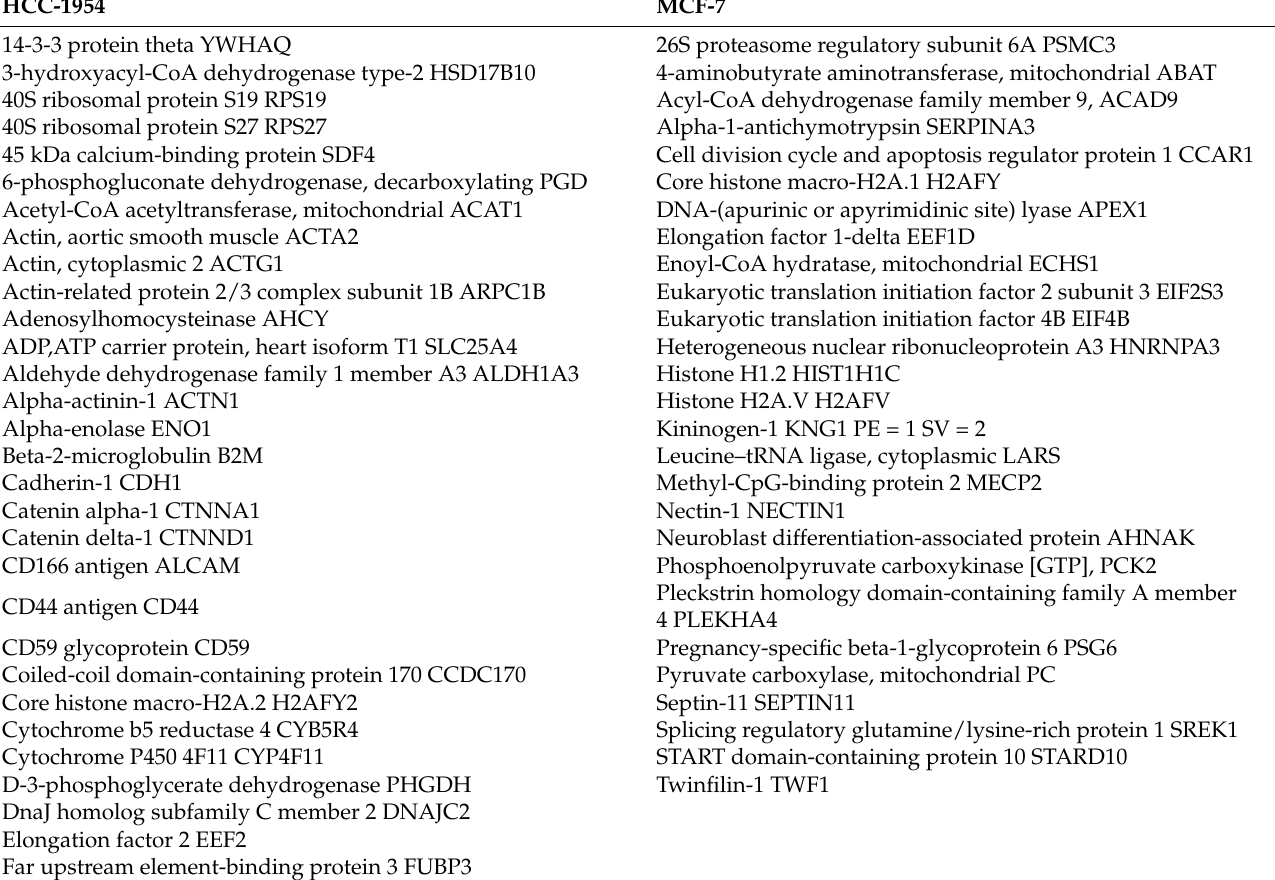
Table 1. Proteins from ME fractions that were relatively increased when compared to FT